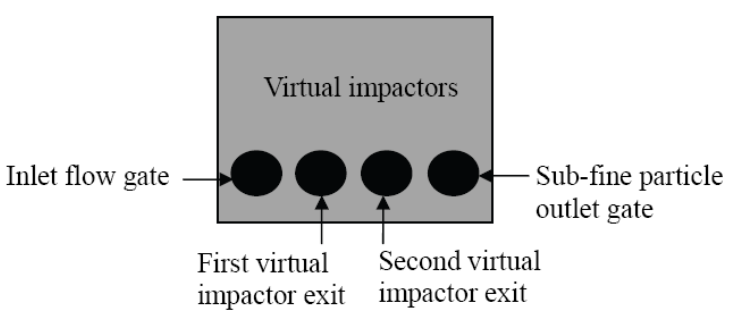
Figure 6. Four gates of the combination of two virtual impactors.